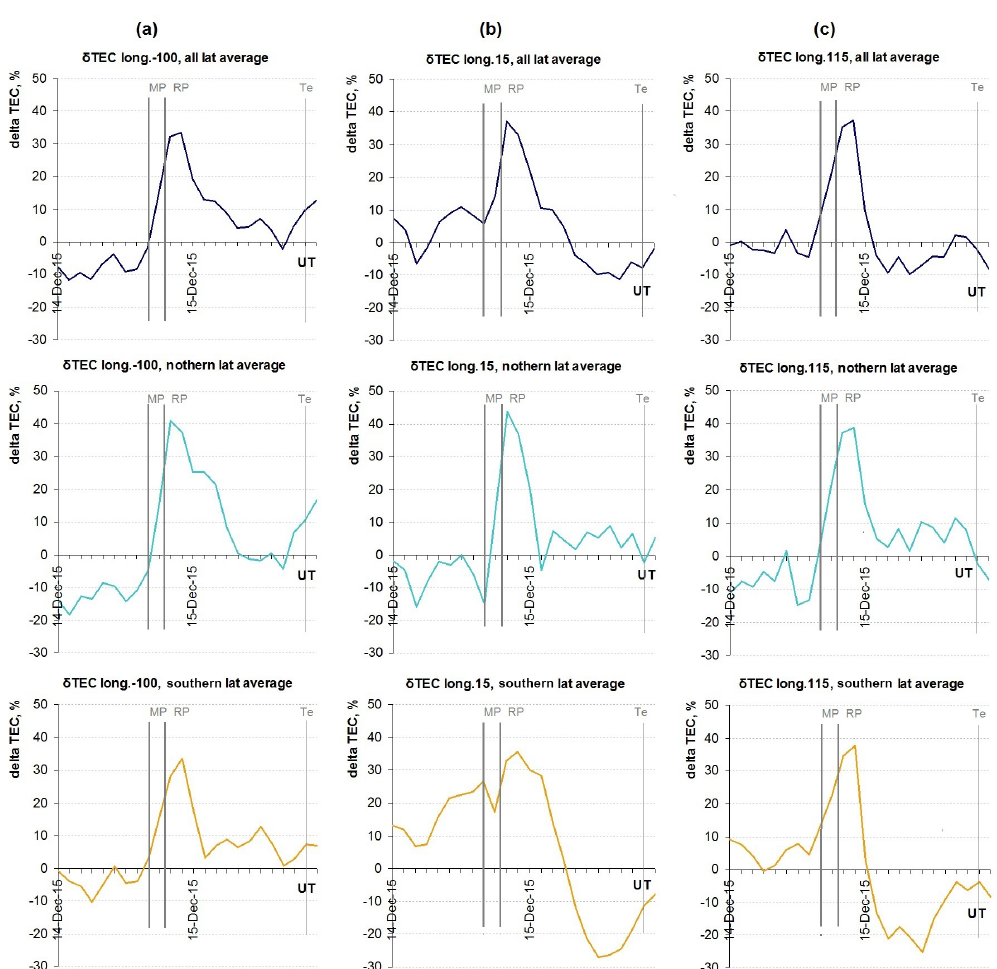
Figure 6. Results for storm no. 1: δ TEC averaged along the whole meridian (upper panels), along the Northern Hemisphere latitudes (middle panels) and along the Southern Hemisphere latitudes (lower panels) along the American (a) , Euro-African (b) and Asian-Australian (c) meridians. MP and RP beginnings and Te are marked by vertical